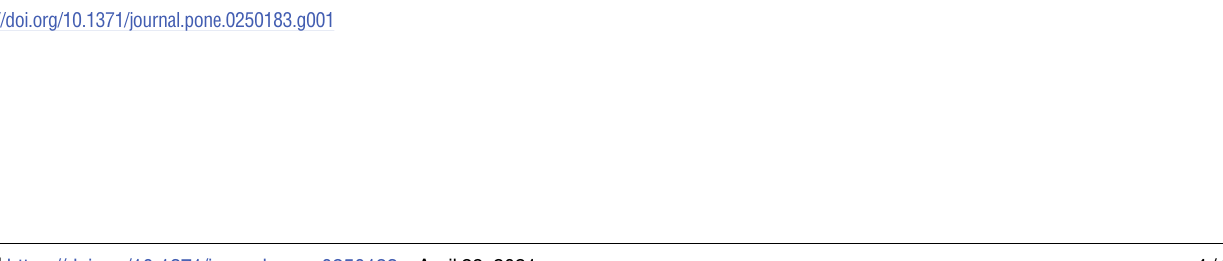
PLOS ONE | https://doi.org/10.1371/journal.pone.0250183 April 29, 2021 4 /